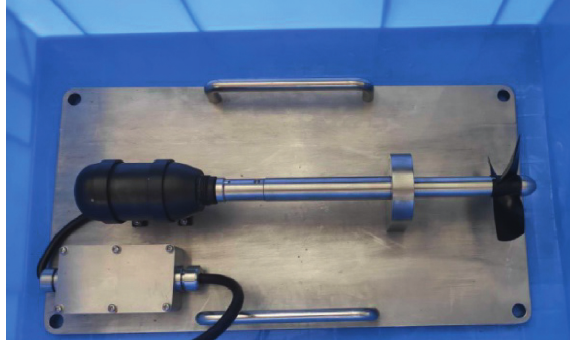
Figure 5: Underwater propeller platform.